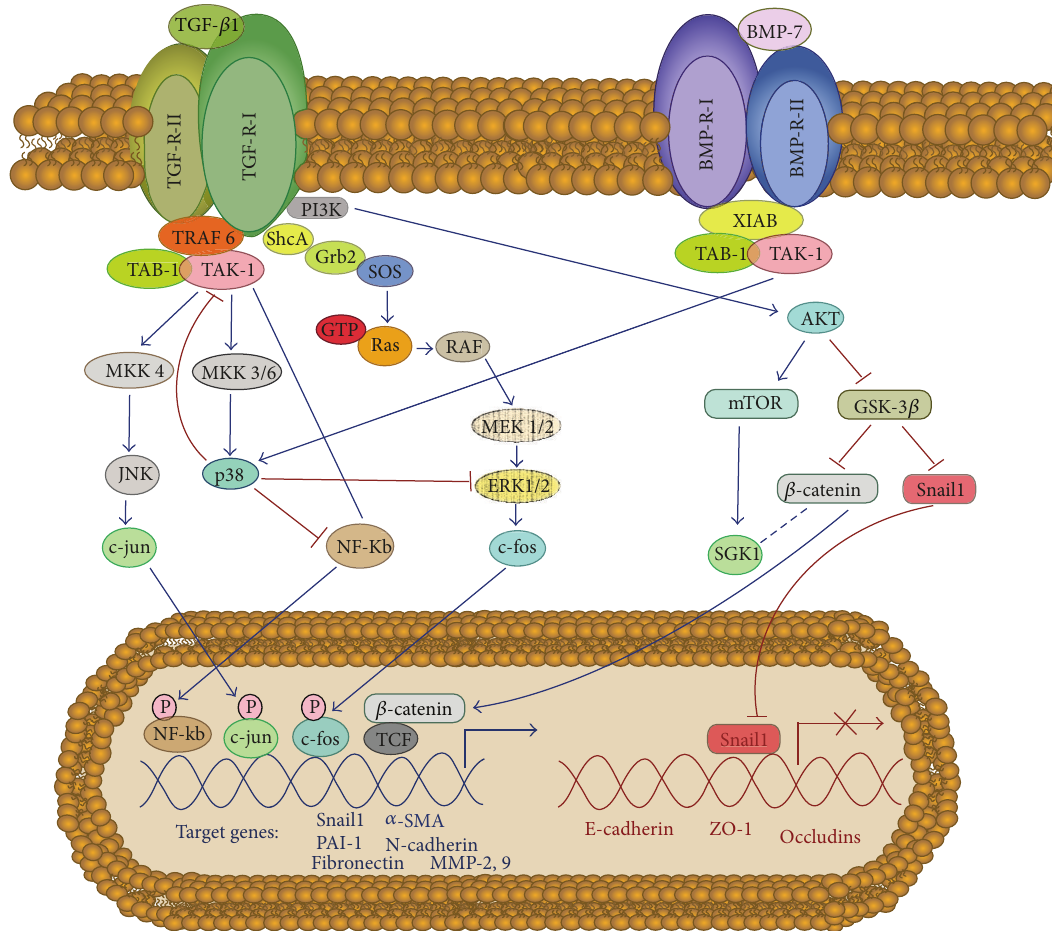
Figure 5: Non-Smad signaling in response to TGF- 𝛽 1 and BMP-7. TGF- 𝛽 1 activates MAP kinases JNK and p38 signaling and NF- 𝜅 B through the activation of TAK1 by receptor-associated TRAF6. TGF- 𝛽 1 also activates MAP kinase ERK 1/2 signaling through recruitment and phosphorylation of Shc by the TGF- 𝛽 1 type I receptor. In MCs the p38-mediated pathway acts as modulator of the mesenchymal conversion by a feedback mechanism based on the downregulation of ERKs 1/2, NF- 𝜅 B, and TAK-1 activities. Interestingly, BMP-7 activates p38 signaling by receptor-associated XIAB, which may contribute to the maintaining epithelial-like phenotype. TGF- 𝛽 1 also induces PI3-K/Akt pathway leading to the activation of mTOR and the stabilization of 𝛽 -catenin and snail through the inactivation of GSK-3 𝛽 . As a result, 𝛽 -catenin localizestothenucleus,whereitfeedsintotheWntsignalingpathwaybyinteractingwithlymphoidenhancerfactor-1/T-cellfactor(LEF1/TCF) and contributes to the transcription of mesenchymal-related genes. In addition, the nuclear translocation of snail promotes the transcriptional repression of E-cadherin and other intercellular adhesion